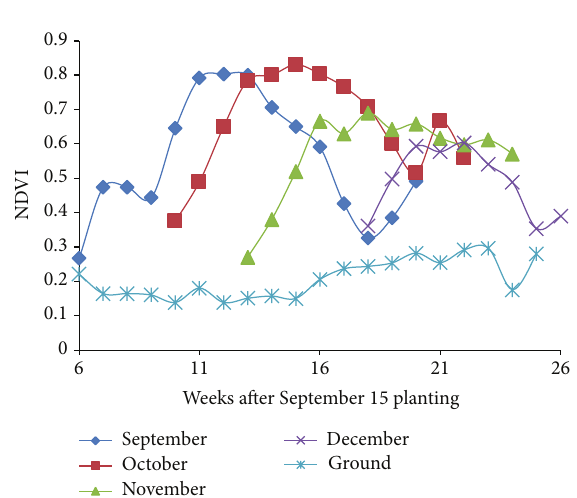
Figure 1: NDVI profiles for the September, October, November, and December crops. November, and December crops, respectively (Figure